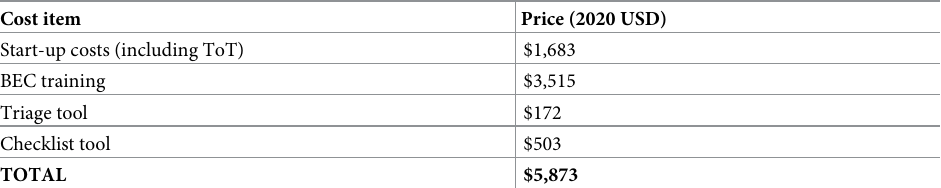
Table 2. Summary of cost variables for the WHO toolkit intervention in